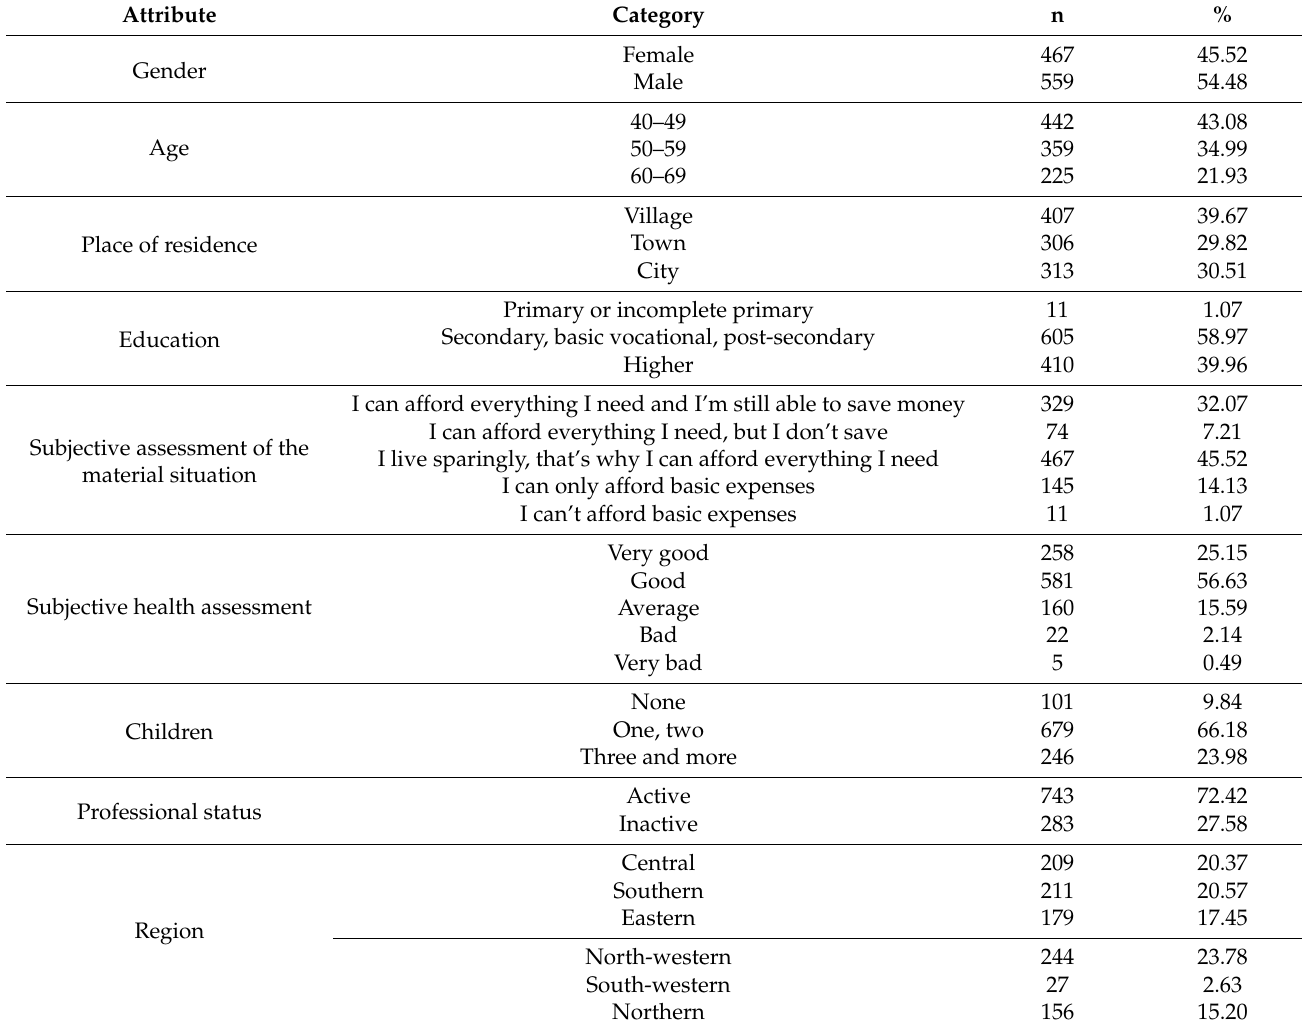
Table 1. Distribution of the research sample by selected